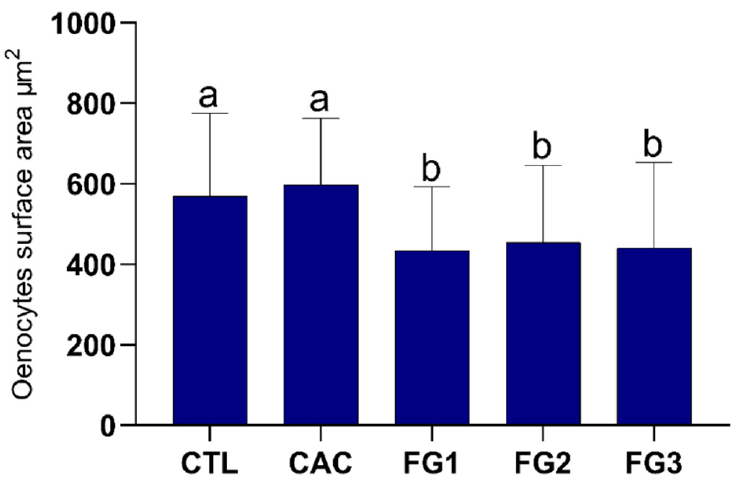
Figure 3. Graph of the surface area of oenocytes from foragers of Africanized honey bee after five days of oral exposure to different treatments. Letters represent significant differences between the experimental groups by the Kruskal–Wallis nonparametric test, followed by Dunn’s multiple comparisons test ( p < 0.05). Kruskal–Wallis statistic = 125.7. N = 5 individuals per experimental group.